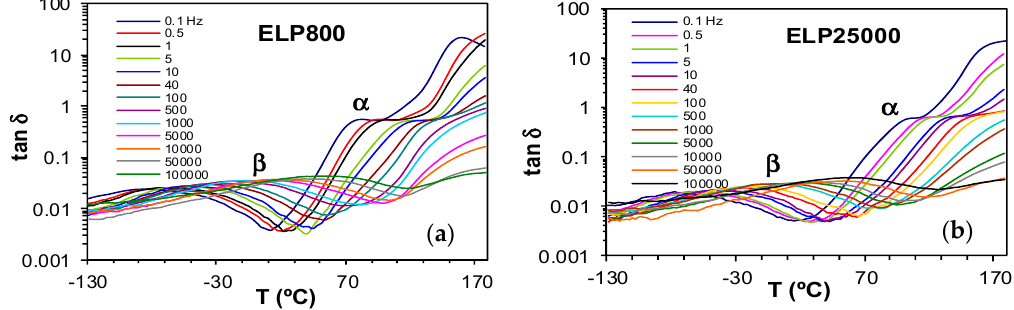
◦ C/min for the fully cured systems: ( a ) ELP800;